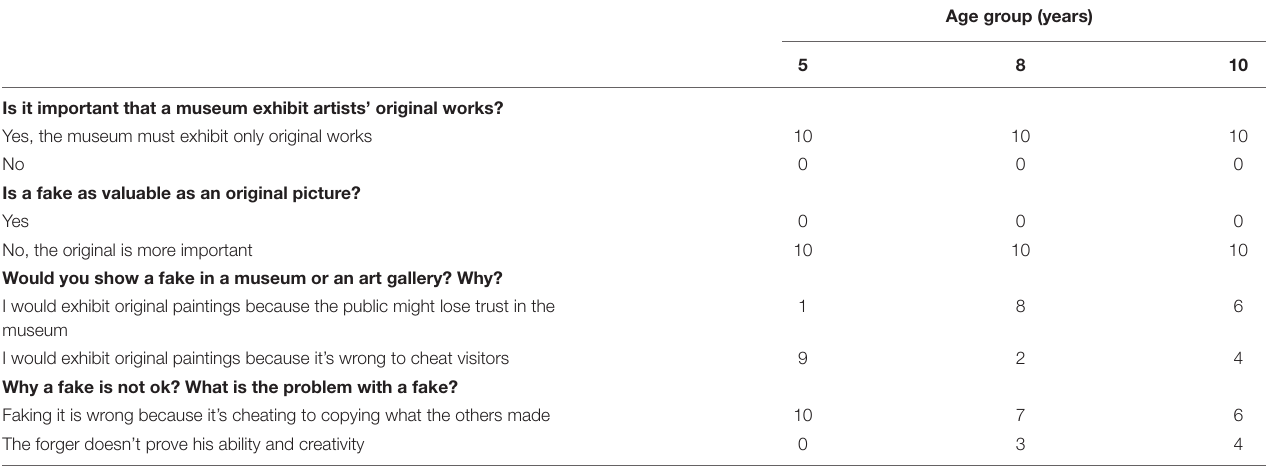
TABLE 4 | Frequency of answers to questions in Study